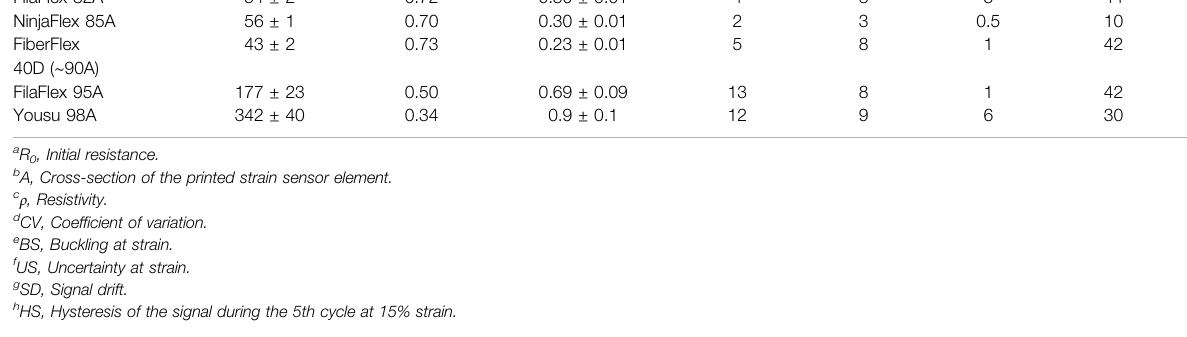
Frontiers in Robotics and AI |